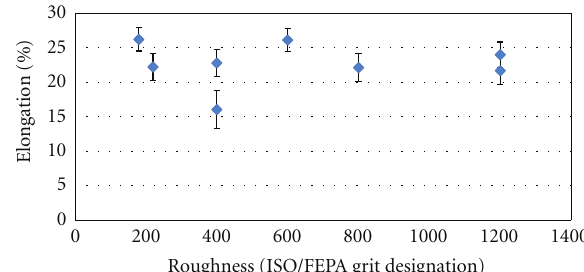
Figure 13: Slow strain-rate test results showing the influence of the surface roughness on the stress-corrosion resistance of steel at 45 ◦ C and